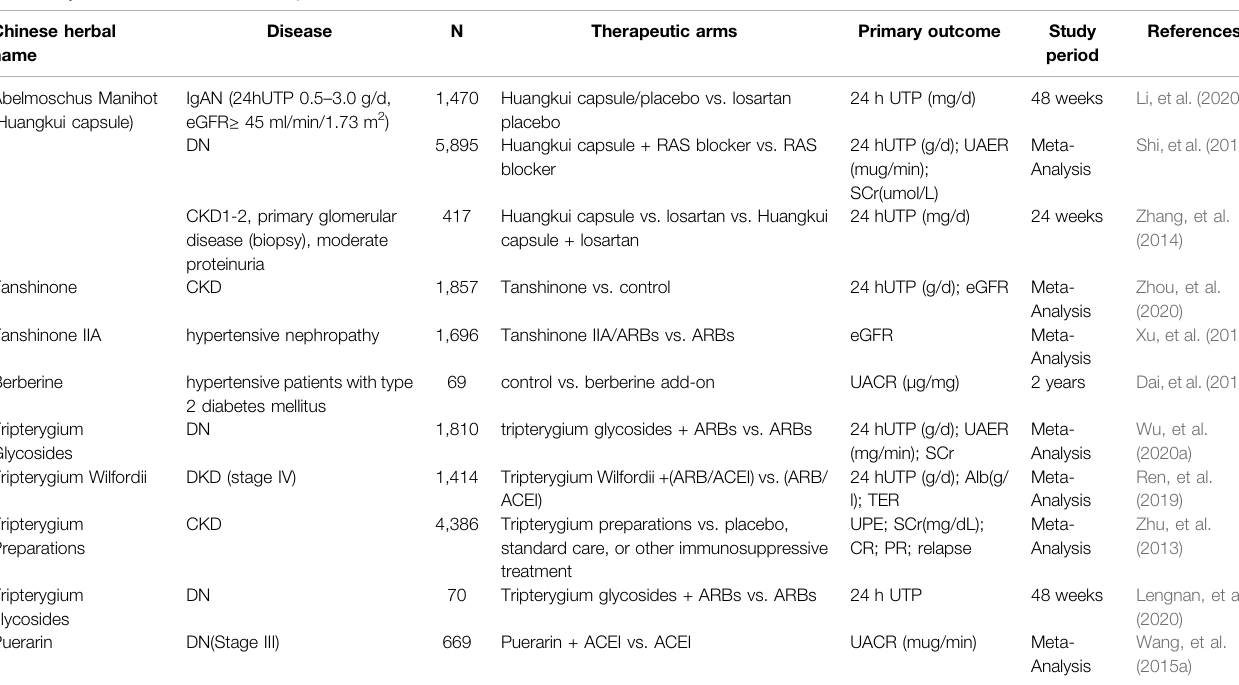
TABLE 2 | Clinical studies on the ef fi cacy of CHM in the